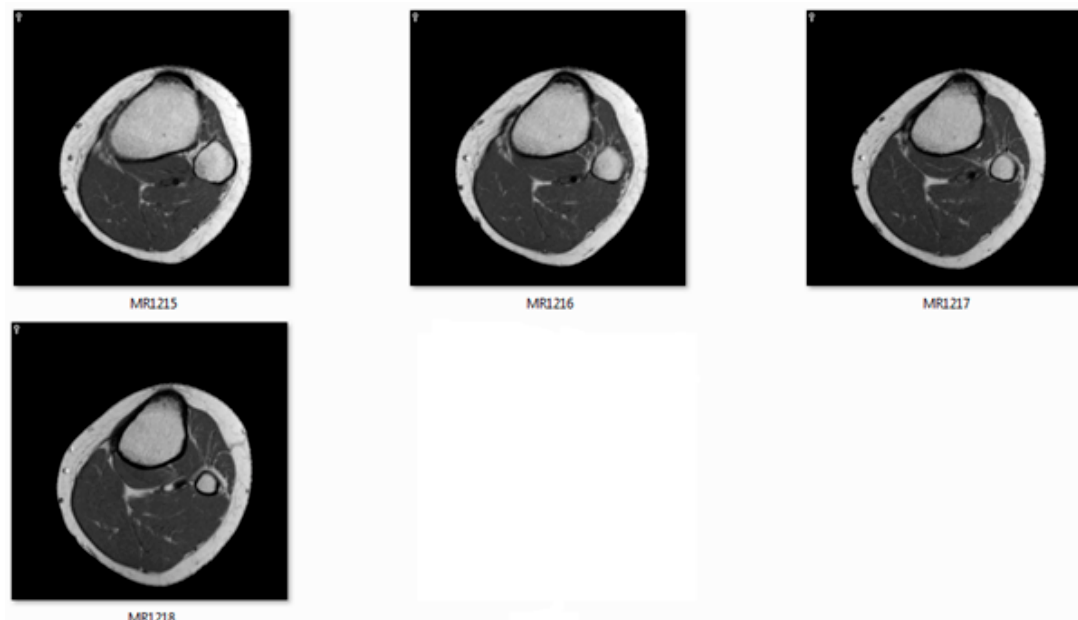
Figure 11. The image slides used as input data.